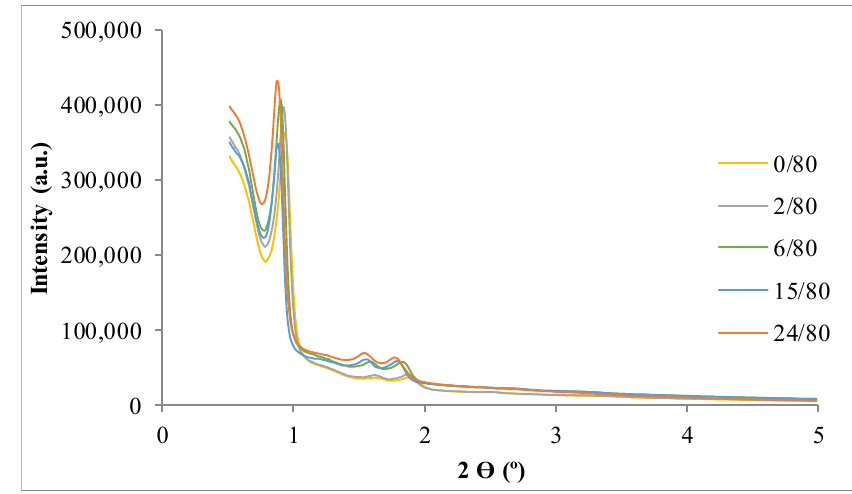
Figure 2. Low angle X-ray diffraction patterns of samples for the study of the influence of time (tH). The unit cell parameter [29], together with the other textural parameters, are shown in Table 1.